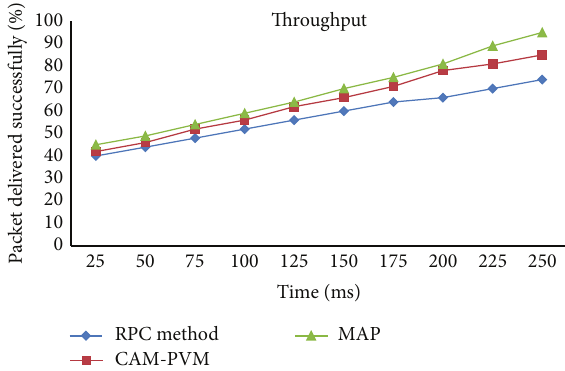
Figure4:ComparisonofthroughputbetweenexistingRPCmethod with CAM-PVM and